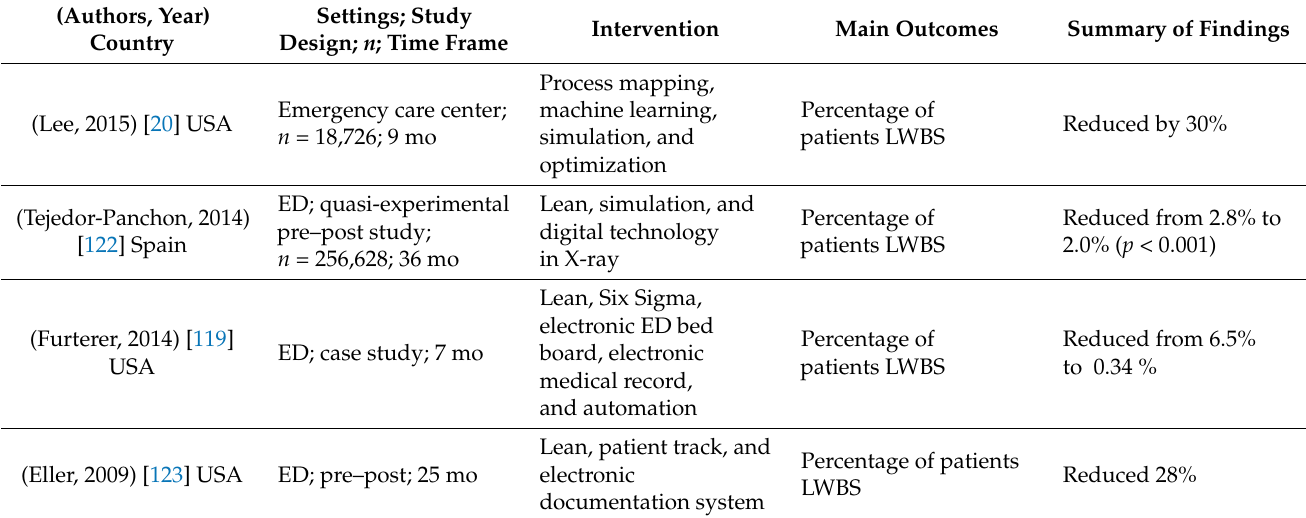
Table 6. Outcomes of LWBS in LH interventions supported by DTs.